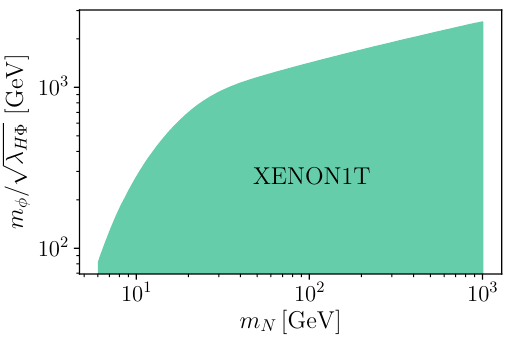
Figure 4: Direct detection constraints from XENON1T [ 54 ] on the mass scale (cid:112) λ m φ / which controls the Wilson coefficient of the operator H Φ have been obtained applying Eq.(30) to the EFT results shown in Figure